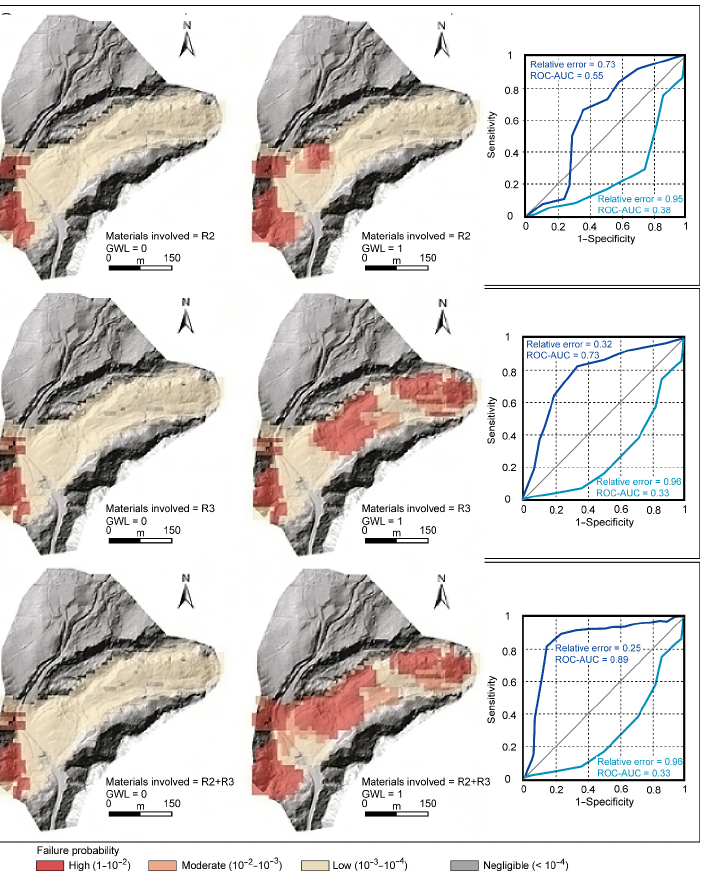
Figure 13. Influence of the type of materials introduced to compute failure probabilities with ALICE ® for the La Médaille landslide. ( a ) Computations with R2; ( b ) computations with R3; ( c ) computations with R2+R3. Hillshade maps were produced with Helimap DTM (2013).